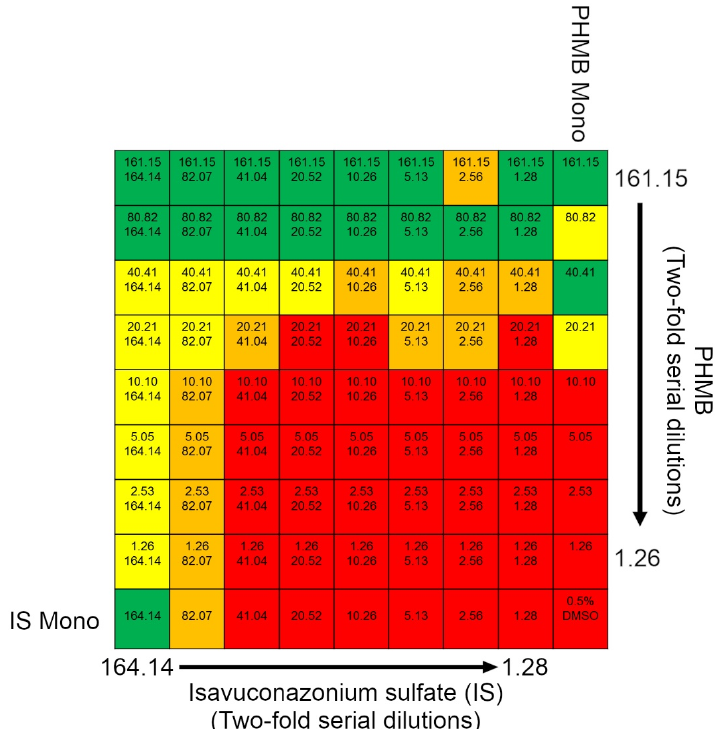
Figure 3. Isavuconazonium-PHMB combination excystation heatmap. Heatmap displaying qualitative scoring of excystation for different isavuconazonium sulfate (IS)–PHMB combination treatments. Top number in grids represents PHMB concentration in μ M, bottom number in grids represents isavuconazonium sulfate concentration in μ M. Green: 0% trophozoite plate coverage; yellow: 0–1% trophozoite plate coverage; orange: 50–80% trophozoite plate coverage; red: 100% trophozoite plate coverage.